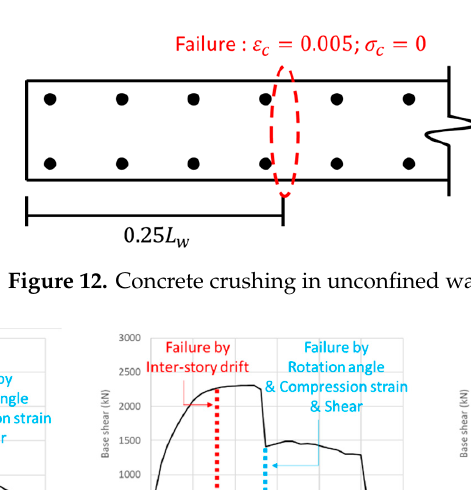
Figure 14. Example of shear failure (Model A, R3).